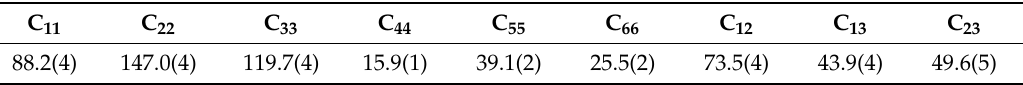
Table 3. Single-crystal elastic moduli of hemimorphite (GPa).